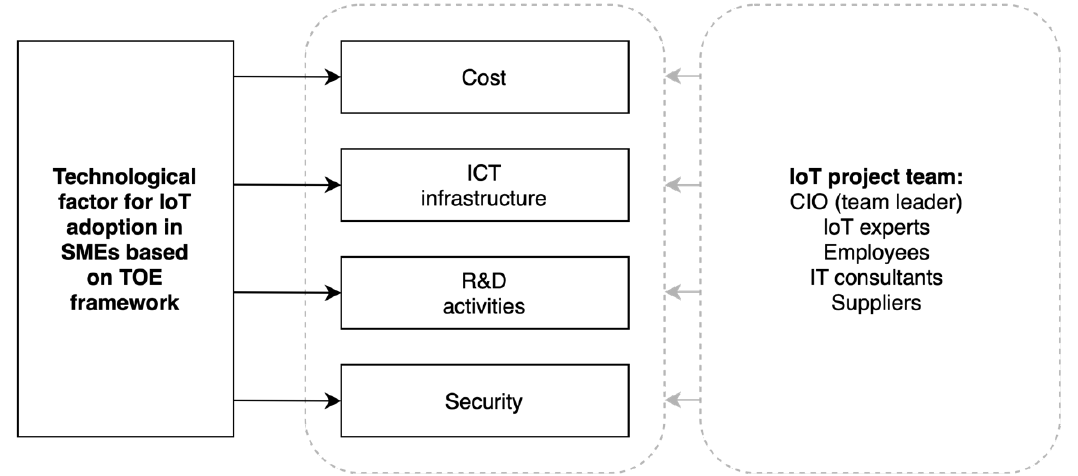
Figure 1. Technological factor for IoT adoption in SMEs based on TOE